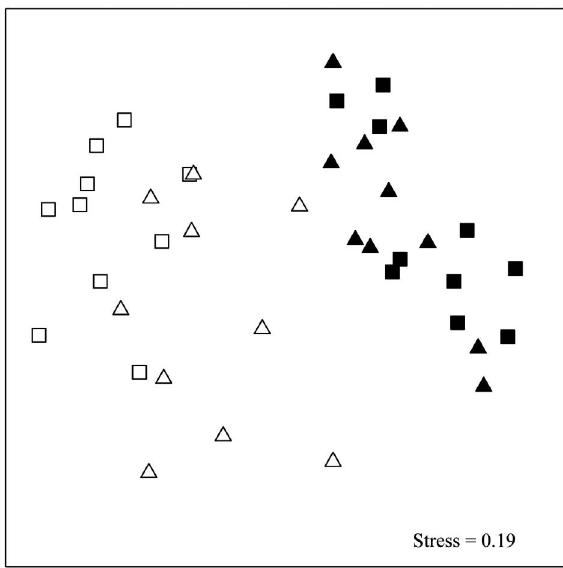
Fig . 1. – nMDS plots of centroids of pools sampled in winter (black) and summer (white), at two dates in each season. Date 1=December 2010 (Winter: full square) and Jun 2011 (Summer: full triangle), Date 2=February 2011 (Winter: open square) and July 2011 (Sum- mer: open